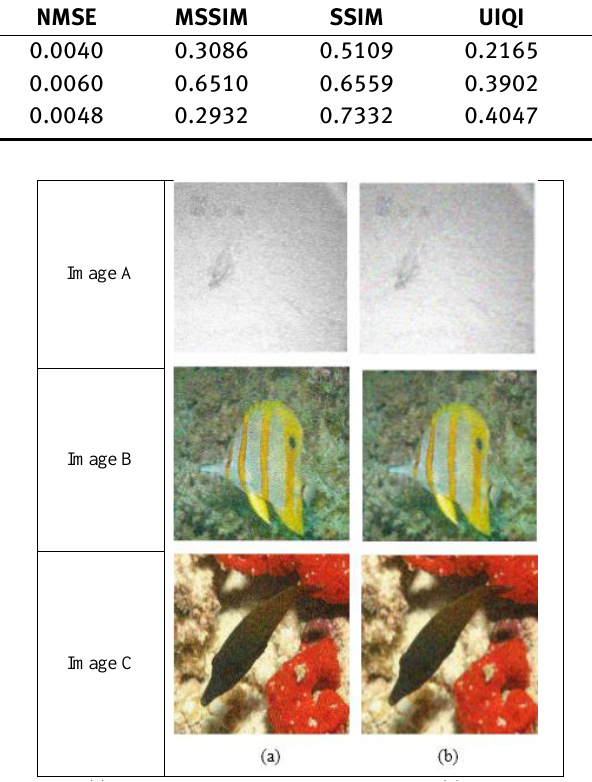
Figure 6: (a) Images with 0.01 Level Gaussian noise, (b) Denoised images Table 3: Performance of modified fuzzy set filter by adding 0.03 level of Gaussian noise Image Gaussian noise=0.03 Level